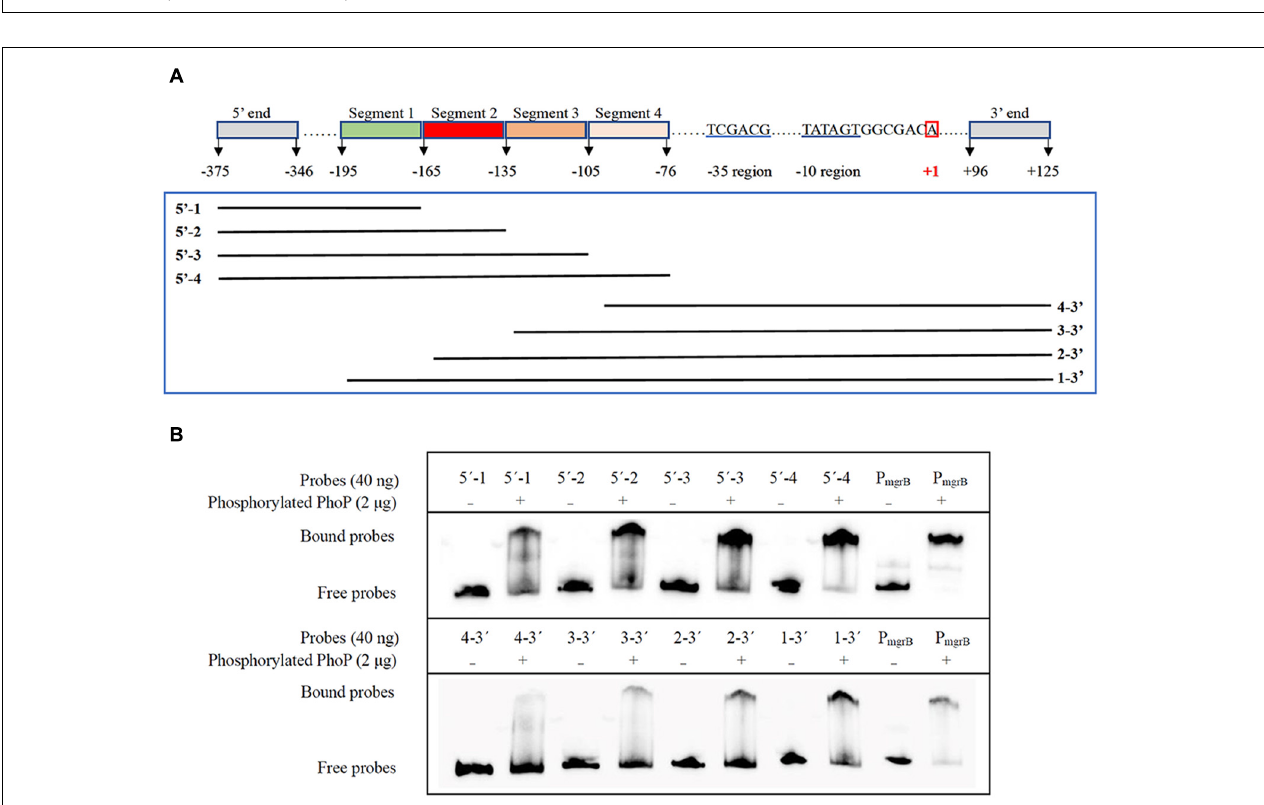
FIGURE 5 | Determination of the PhoP-binding fragment in the promoter of folA using EMSA assay. (A) Nucleotide sequence of the folA promoter regulatory region. The numbering of the sequence is relative to the start site of transcription indicated with red box. The –35 and–10 regions of the folA promoter are underlined in blue. Segment 1 (–195/–166), segment 2 (–165/–136), segment 3 (–135/–106), and segment 4 (–105/–76) are indicated with highlights or underlines. The two sets of probes of gradually shortened folA promoter fragments are framed in green. (B) Binding of PhoP to the probes showed in (A) , and the binding of PhoP to the promoter regions of mgrB was used as the positive control. The experiment was repeated at least three times and a representative result was presented.